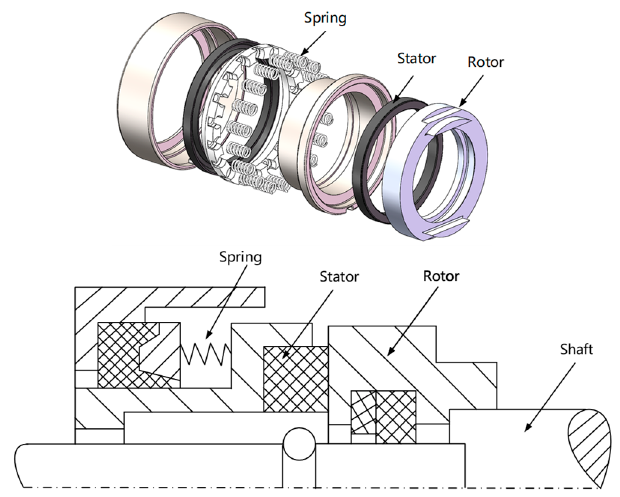
Figure 1. Schematic diagram of the mechanical seal structure.